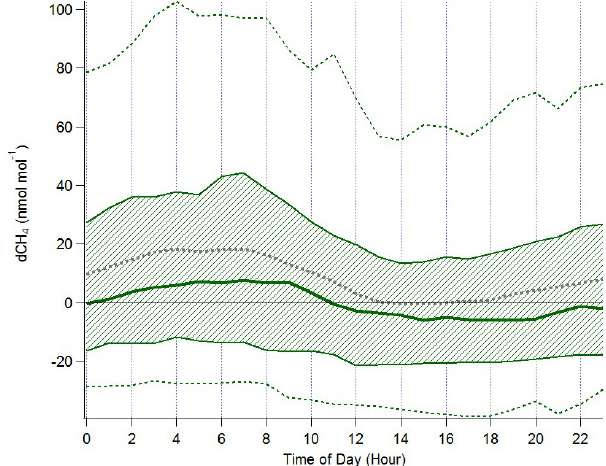
Fig. 5. Mean (gray dashed line) and median (bold green) diurnal cy- cle of change in CH 4 mixing ratio (dCH 4 ) , with interquartile range (shaded area), and the 5th and 95th percentile range (indicated by green dashed lines) normalized to the median